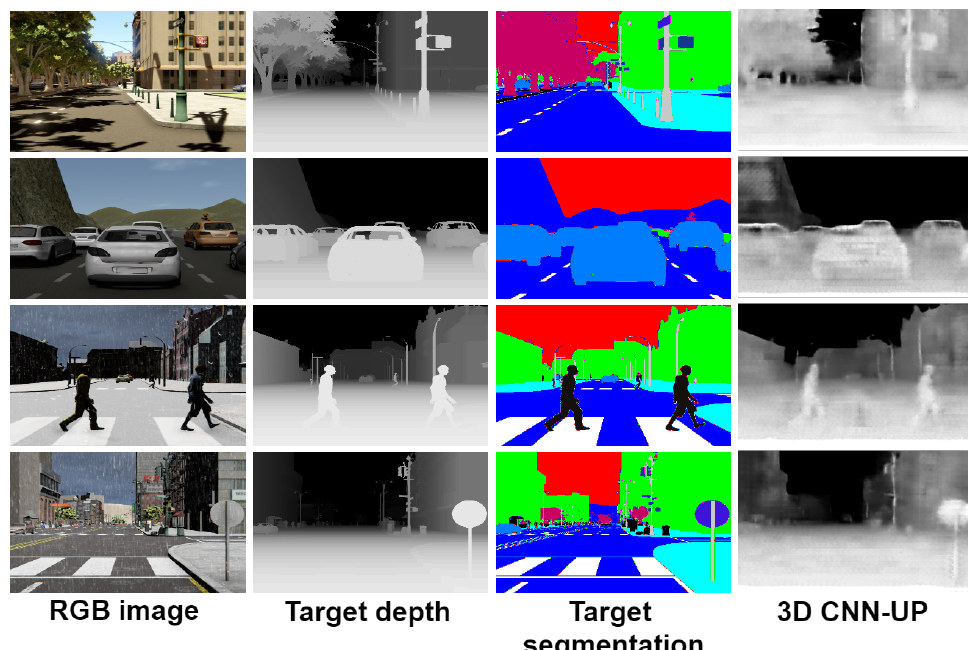
Figure 20. Results from the 3D CNN-UP visually enhanced; this model uses the segmentation given by the dataset.